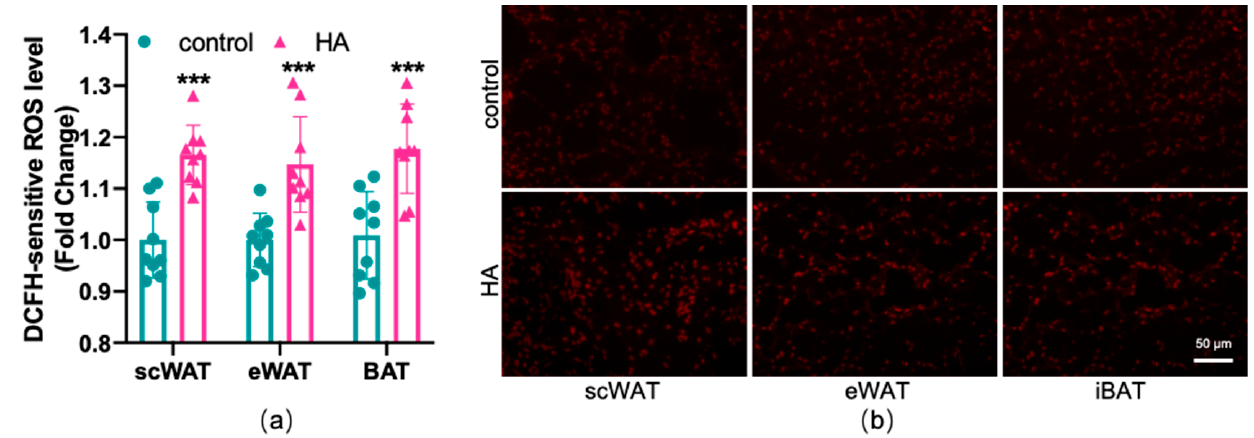
Figure 3. Effect of HA exposure on ROS generation in adipose tissue. ( a ) ROS generation determined by DCFH-DA ( n = 9). ( b ) Representative images of fat pad sections stained with dihydroethidium (DHE) staining. The results are presented as the mean ± SEM of three independent experiments. *** p < 0.001, compared with the control group.